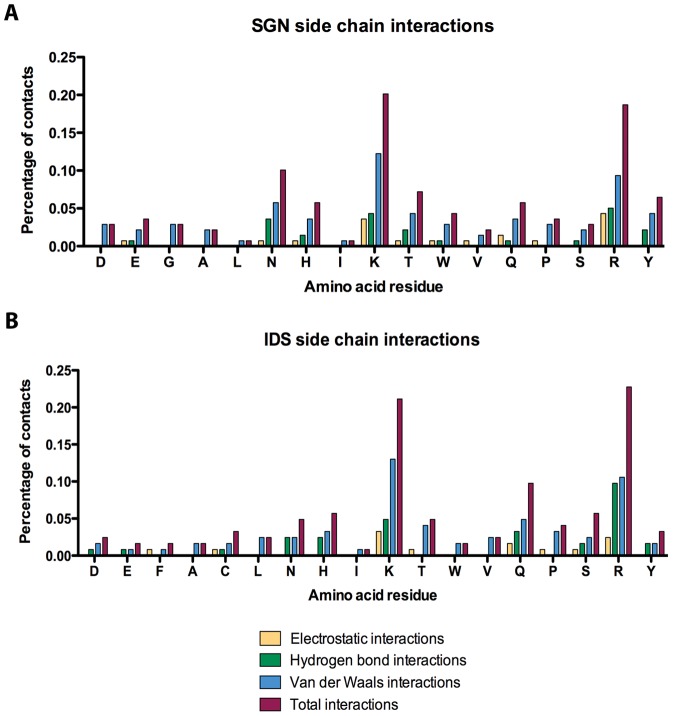
Summary of side-chain amino acid interactions for protein-heparin complexes deposited in the PDB.Molecular contacts were inspected for (A) SGN and (B) IDS, the two major components of heparin. The fraction of contacts is represented for each amino acid.